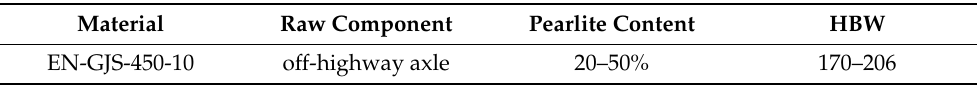
Table 4. Pearlite content and Brinell hardness of tested